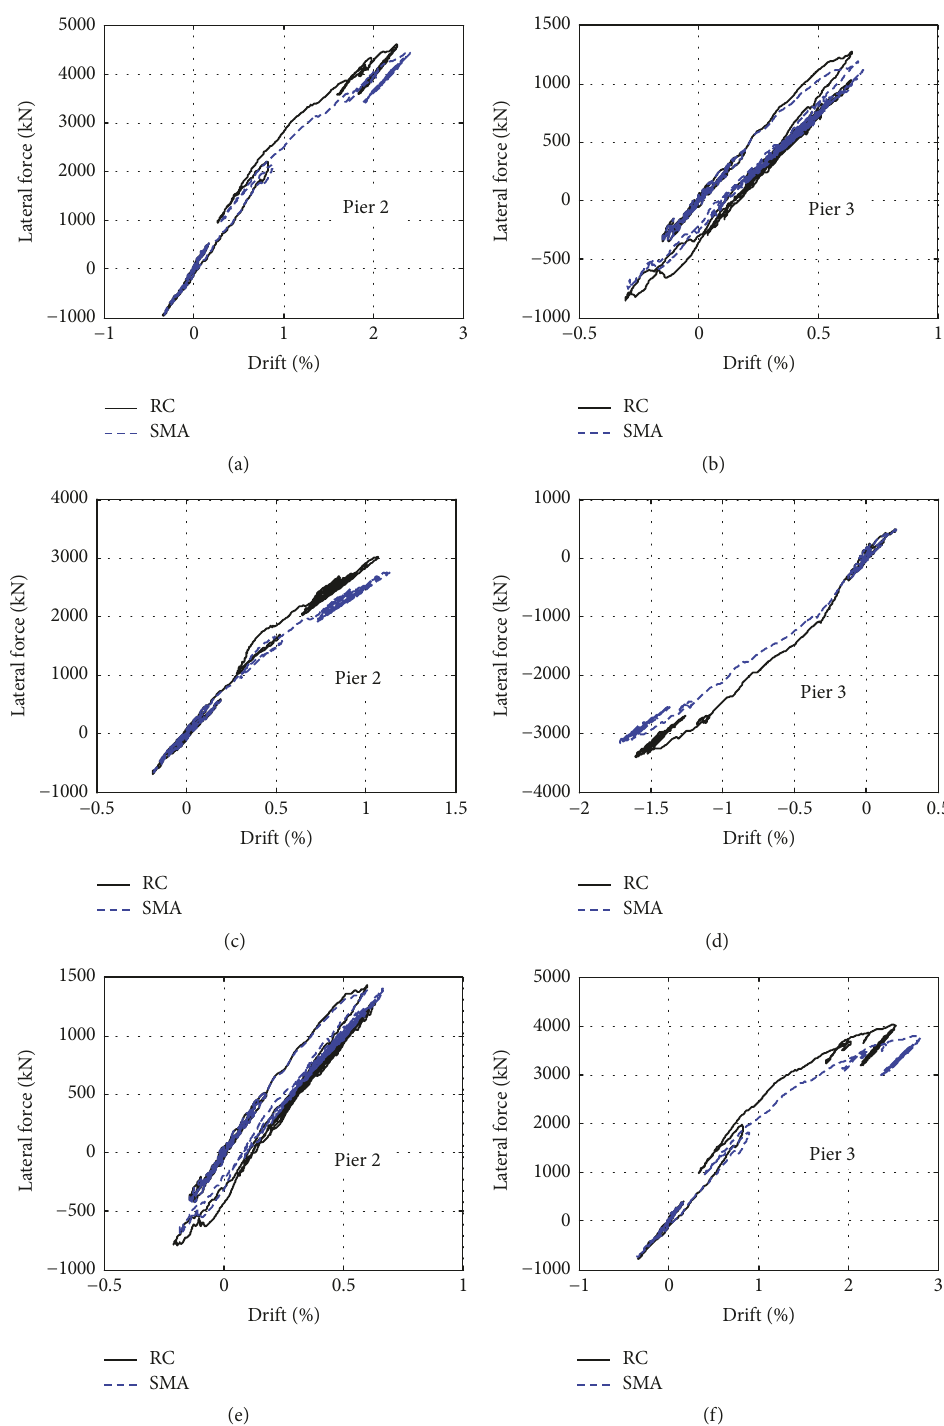
Figure 13: Calculated force displacement hysteresis of the column: (a) Pier 2 in Case 1, (b) Pier 3 in Case 1, (c) Pier 2 in Case 2, (d) Pier 3 in Case 2, (e) Pier 2 in Case 3, and (f) Pier 3 in Case